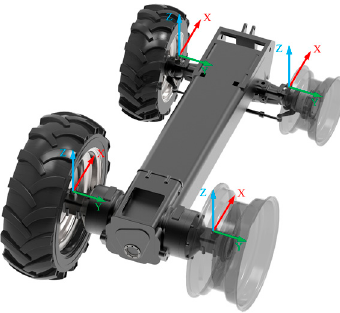
Figure 2. Installation of four vibration sensors for measuring acceleration signals.